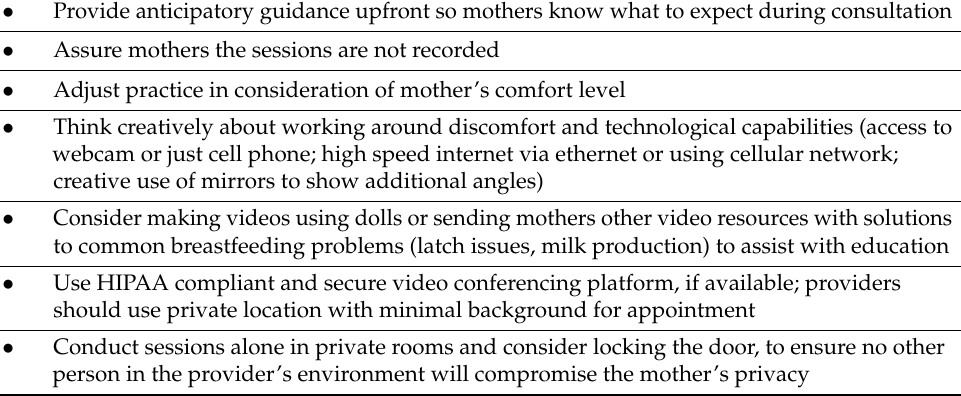
Table 5. Key points of consideration regarding